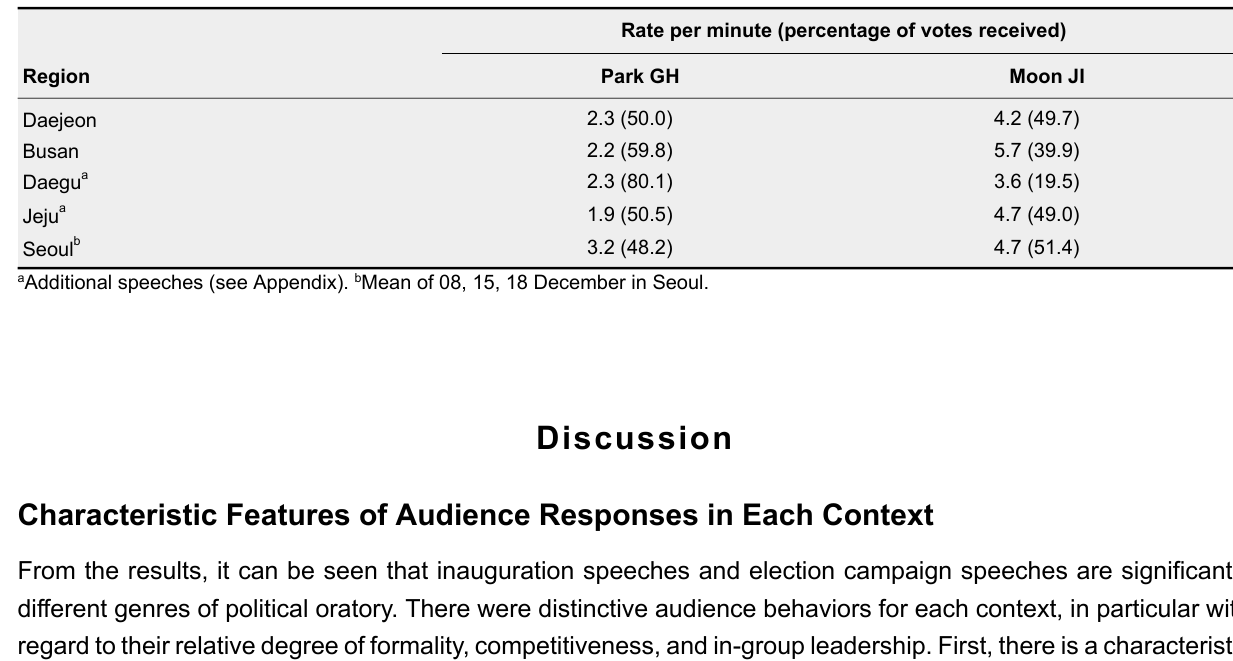
Response Rate and Electoral